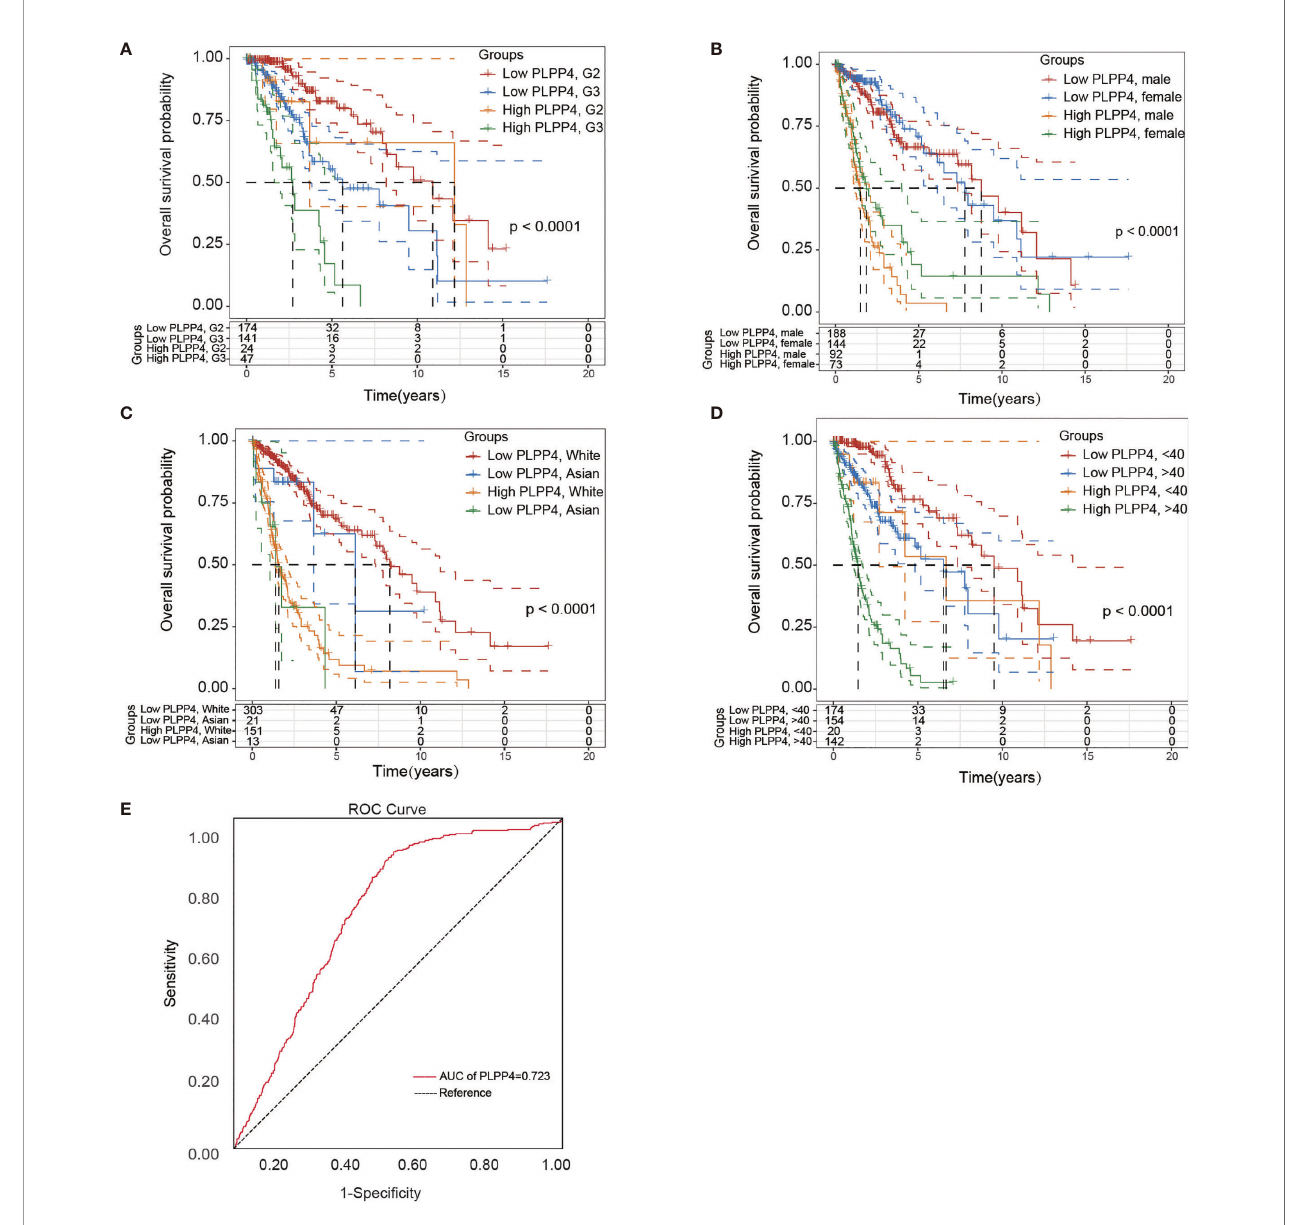
FIGURE 6 | Over survival and ROC analysis of PLPP4 signature risk score in glioma. (A – D) Over survival analysis based on the effect of tumor grade, gender, race, and age. (E) ROC analysis of the sensitivity and speci fi city of the prognosis prediction based on overall survival. AUC, area under the ROC